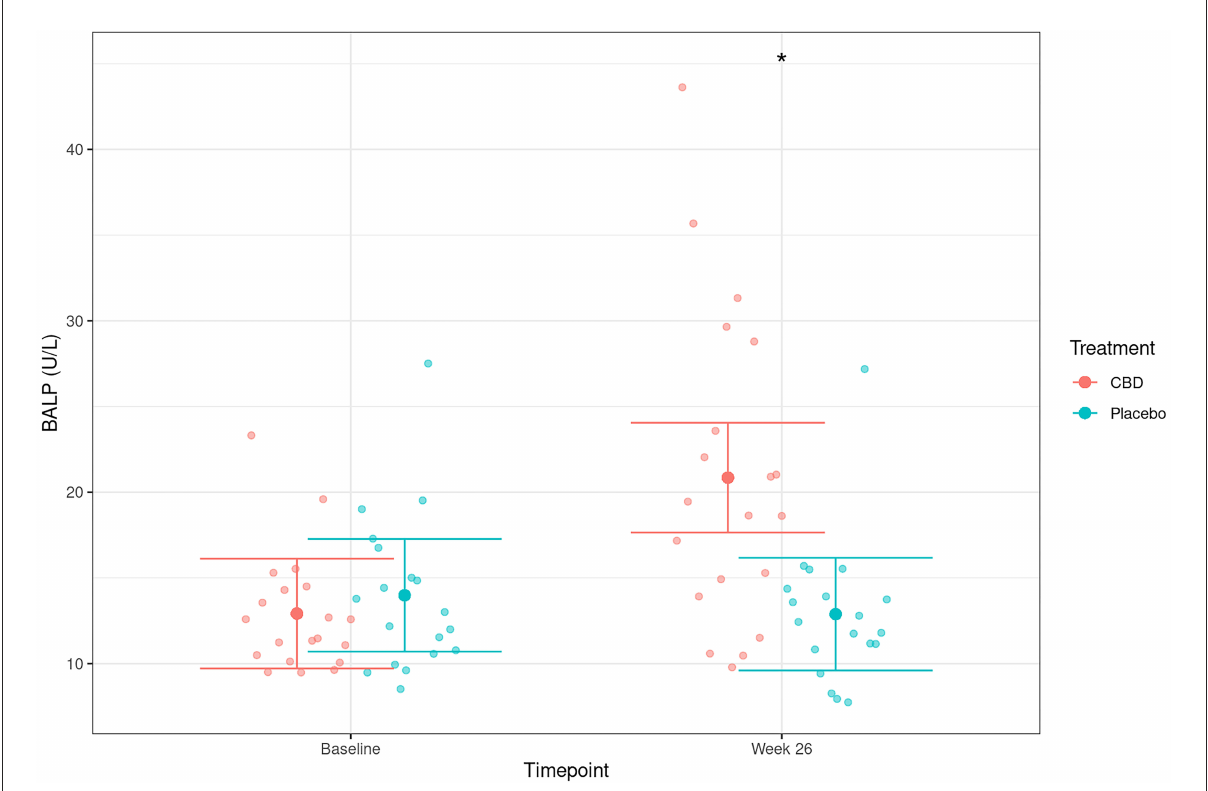
FIGURE5 Serum activity levels of bone-specific alkaline phosphatase (BALP; mean and 95% confidence intervals) in dogs dosed with CBD (red) and placebo (blue) at baseline and 26 weeks. *Depicts significant differences between the experimental groups ( p < 0.001).